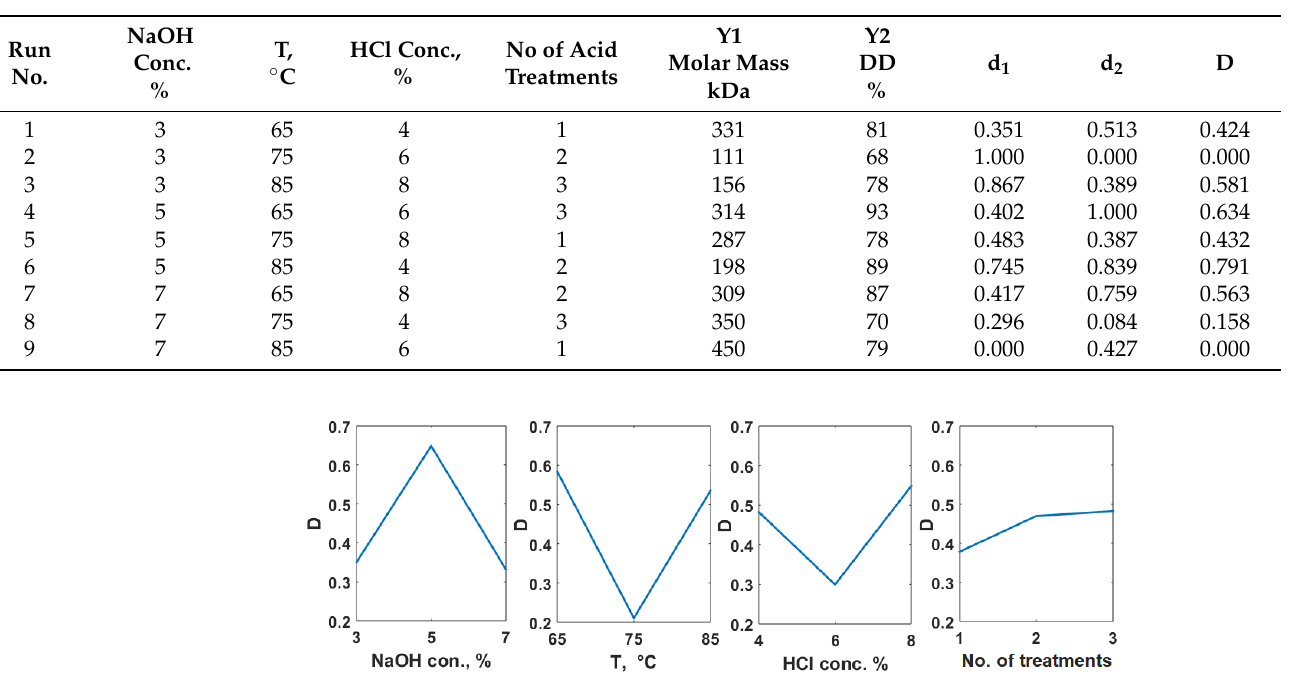
Table 4. Individual and global desirability for maximum deacetylation degree and minimum mo- lar mass.